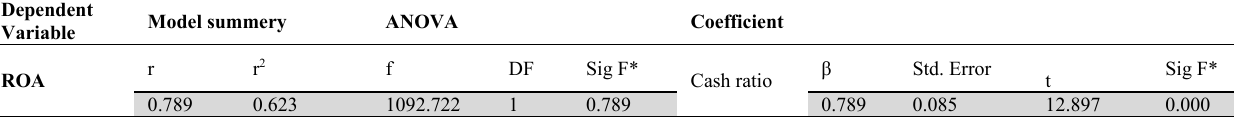
Simple regression test results, the effect of cash ratios at return on assets Dependent Model summery ANOVA Variable